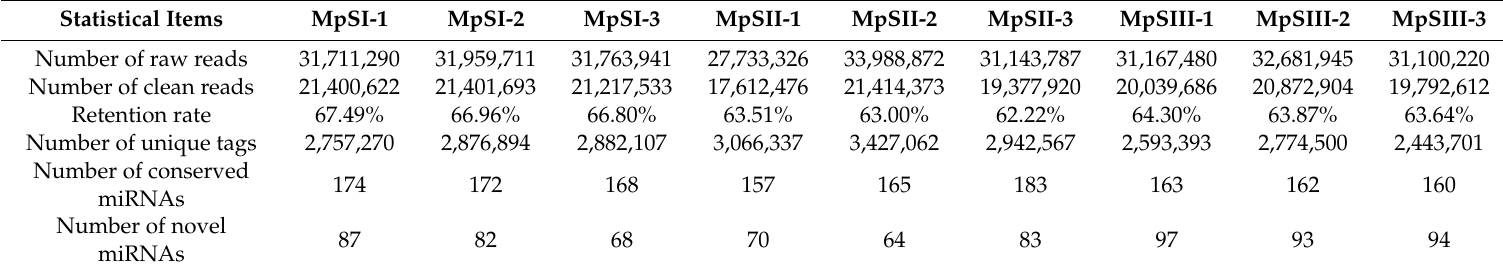
Table 1. Statistics of sequencing reads and miRNAs.